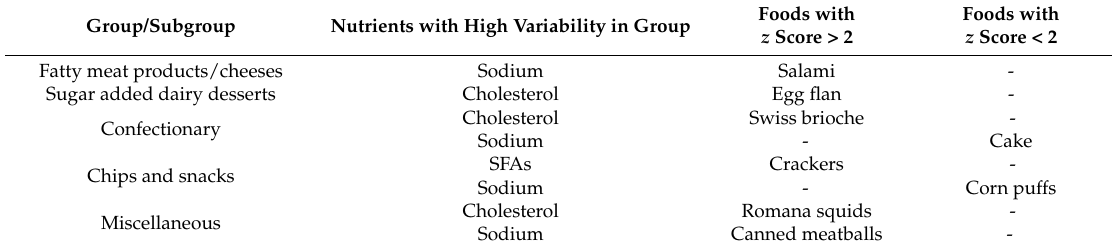
Table 4. Foods with z -values outside limits in relevant nutrients of the groups. A frequent choice of these foods may upset this nutrient